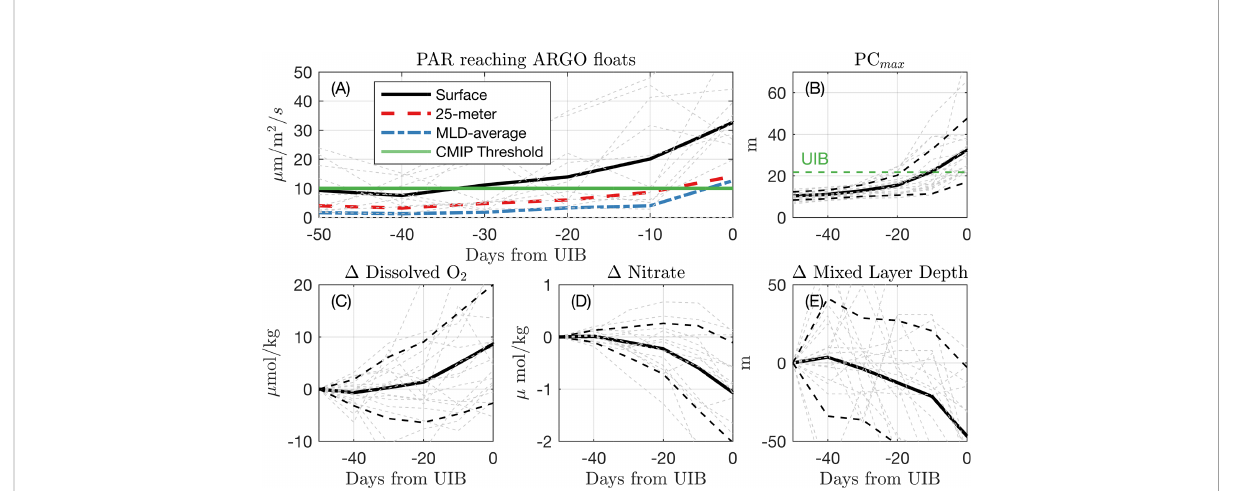
FIGURE 2 Under-ice conditions preceding UIBs. (A) Averaged estimated PAR for each of the 12 measured “ UIBs ” for the fi rst pro fi le identi fi ed as a UIB and the fi ve preceding under-ice pro fi les. The black line is the average surface PAR. The red dash line is the average PAR over top 25 m. The blue dot – dash line is PAR averaged over Argo-measured mixed layer depth. The green line indicates the PAR threshold used to de fi ne UIBs in CMIP6 data. (B) (C) Change in dissolved oxygen at depth of Chl$_{max}$, relative to the value recorded 50 days (5 dives) preceding the fi rst UIB measurement. (D – E) , same as (C) for (D) nitrate at depth of Chl$_{max}$, and (E) mixed layer depth. Dashed lines indicate standard deviation of pro fi le